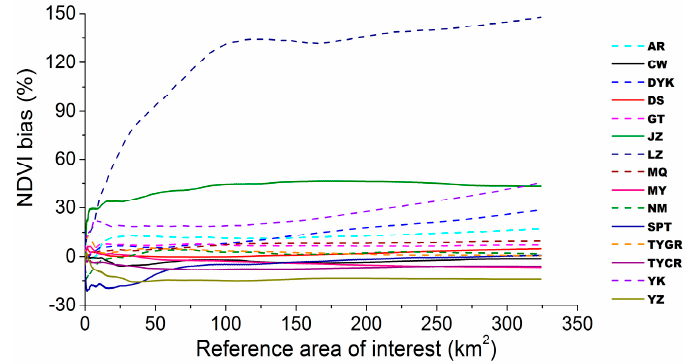
Figure 5. Variations of biases of Normalized Difference Vegetation Index (NDVI) along with the increasing area of reference.